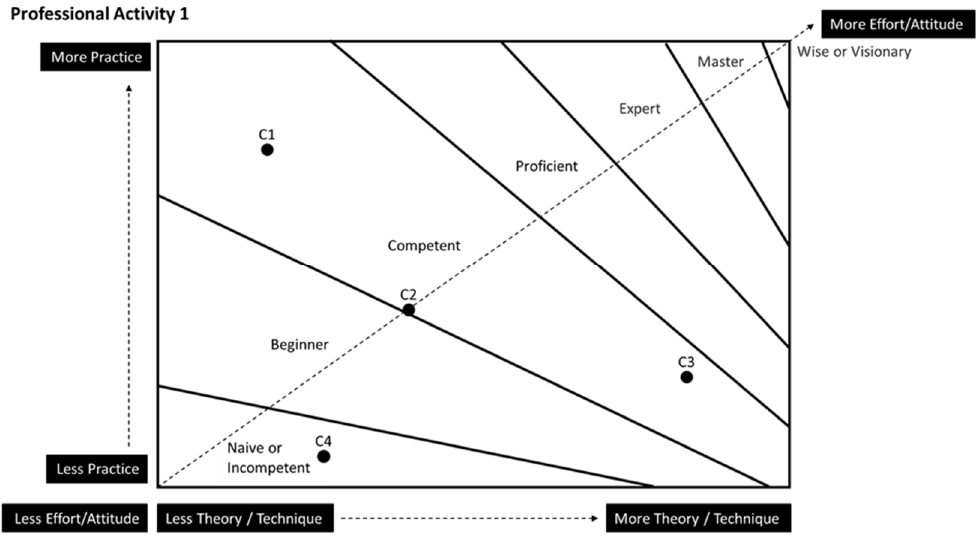
Figure 6. Possible evolution of a doctor’s skills.